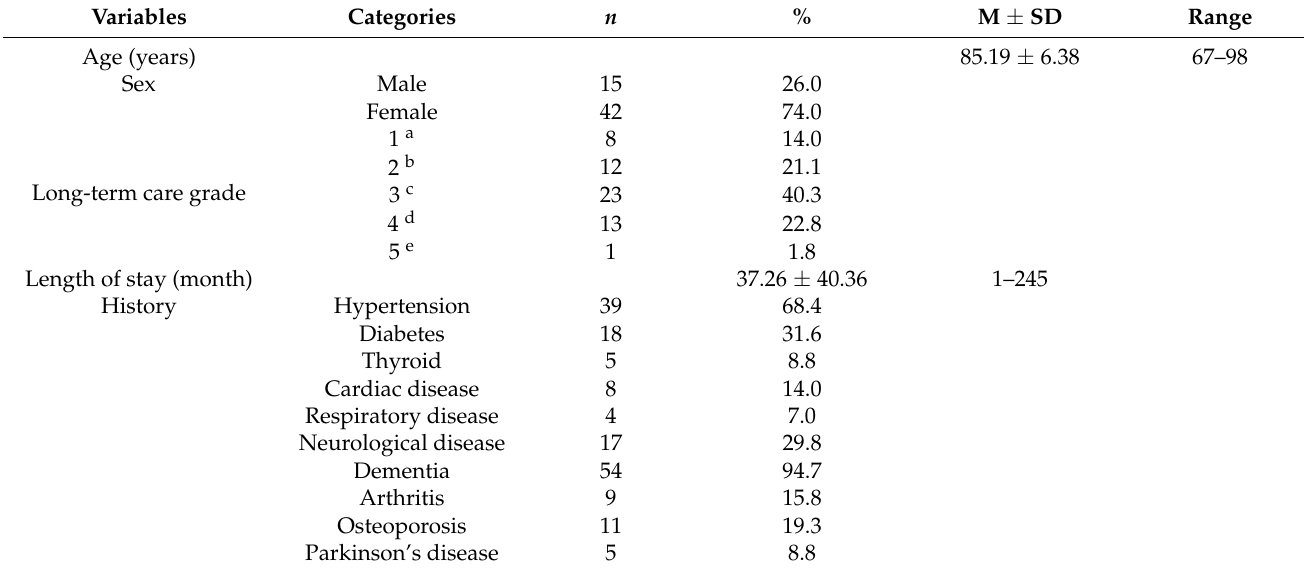
Table 1. Residents’ General Characteristics ( n = 57).